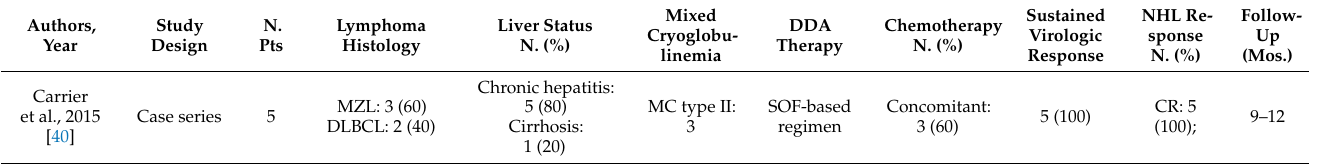
Table 3. DAA therapy in patients with low-grade non-Hodgkin